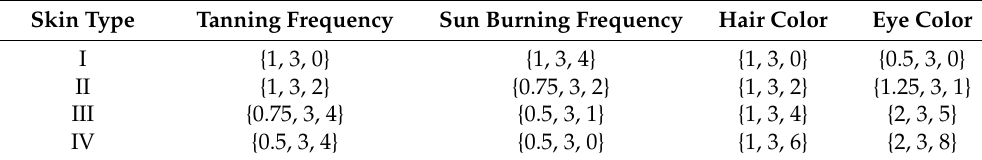
Table 3. Values for the { a x , s , b x , s , c x , s } parameters.